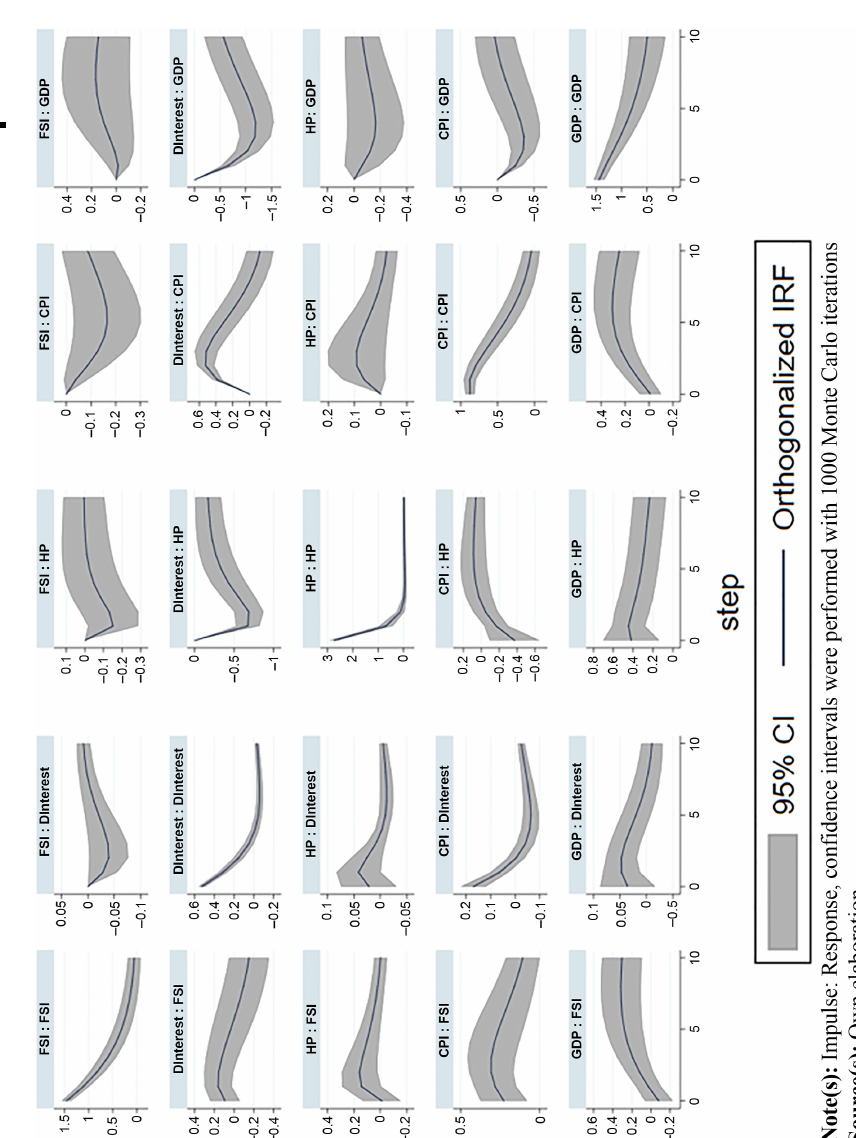
Figure 3. IRFs of the extended model for emerging